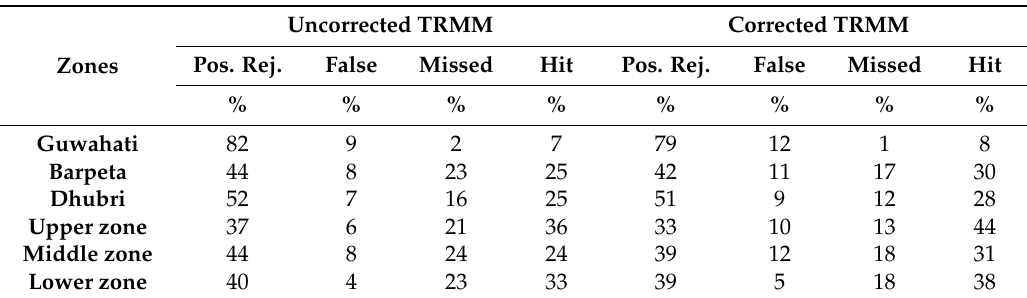
Table 4. Contingency table for the flood event of 23-09-2012. The numbers show the percentage of pixels of inundation maps falling into the four groups: positive rejection, false alarm, missed alarm and hits for the six chosen geographic locations.